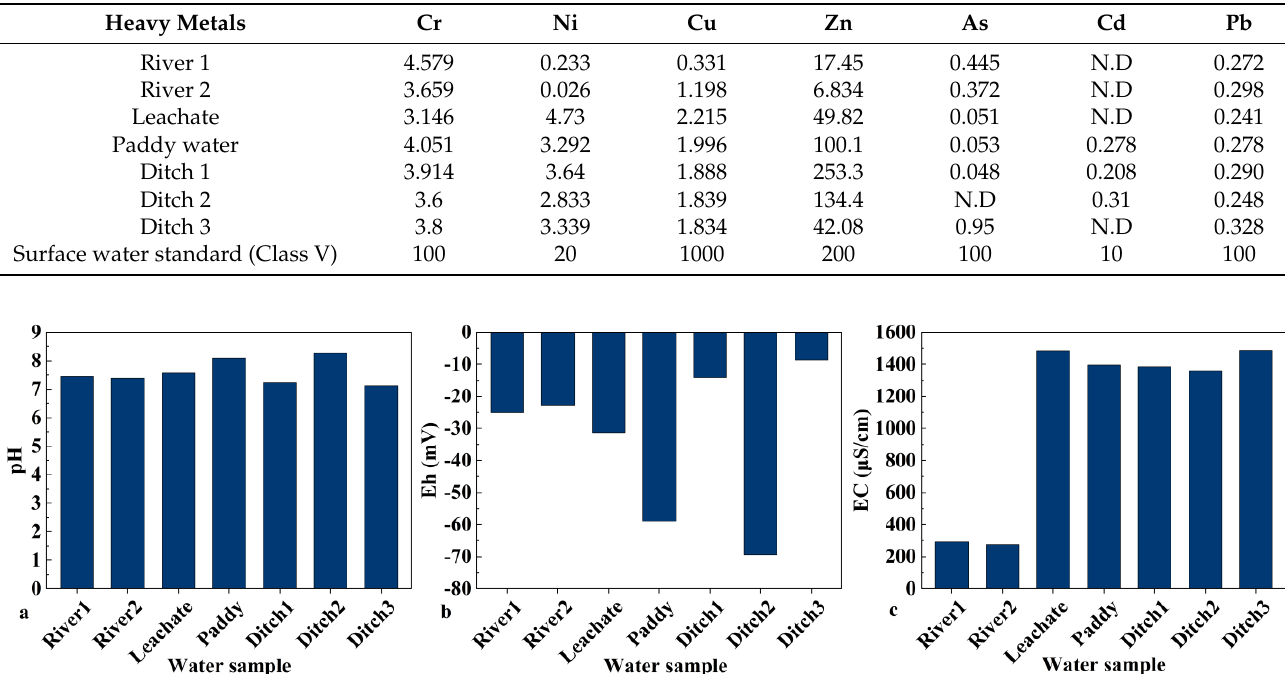
Table 4. Concentrations of heavy metals in water samples and respective national standard values for Class V surface water (mg/kg).